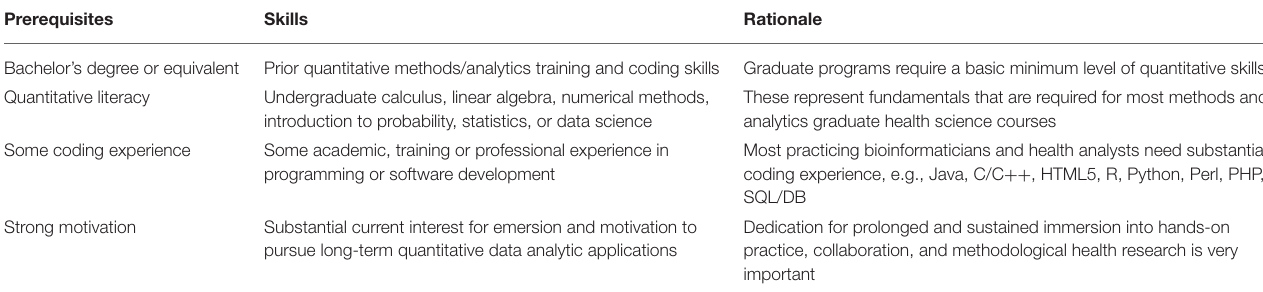
TABLE 1 | Examples of prerequisites for strong biomedical and health sciences quantitative doctoral programs. Prerequisites